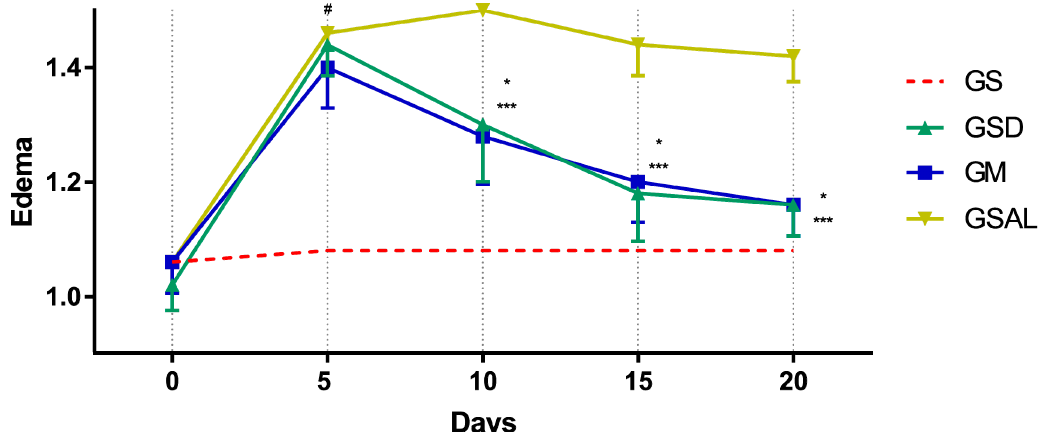
Figure 4. Effect of the crude extract of S. dulcis on the edematogenic evaluation of the circumference of the knee by the pachymeter. Results were expressed as mean ± standard mean error; # difference between GS and GSAL in D5 ( p ˂ 0.0001), GS and GSD in D5 ( p ˂ 0.0001) and GS and GM in D5 ( p ˂ 0.0001); * difference between GSD and GSAL in D10 ( p ˂ 0.0001), D15 ( p ˂ 0.0001) and D20 ( p ˂ 0.0001); *** difference between GM and GSAL in D10 ( p ˂ 0.0001), D15 ( p ˂ 0.0001) and D20 ( p ˂ 0.0001), using 2-way ANOVA with the multiple comparisons test ( p < 0.05).